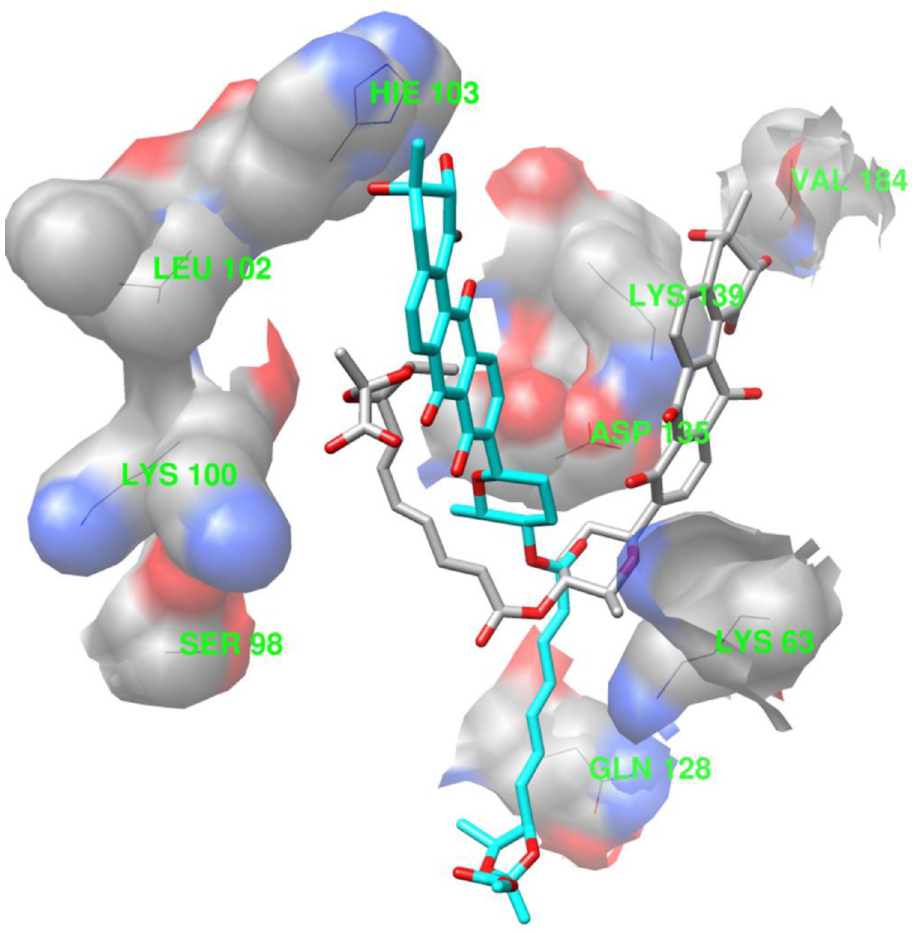
Fig 8. The final snapshots (35 ns) of ligand–protein complexes in the Molecular Dynamics (MD) simulations. The ligands are represented as sticks (gray: waldiomycin; cyan: waldiomycin methyl ester). The proteins are represented as wires of constant colors.